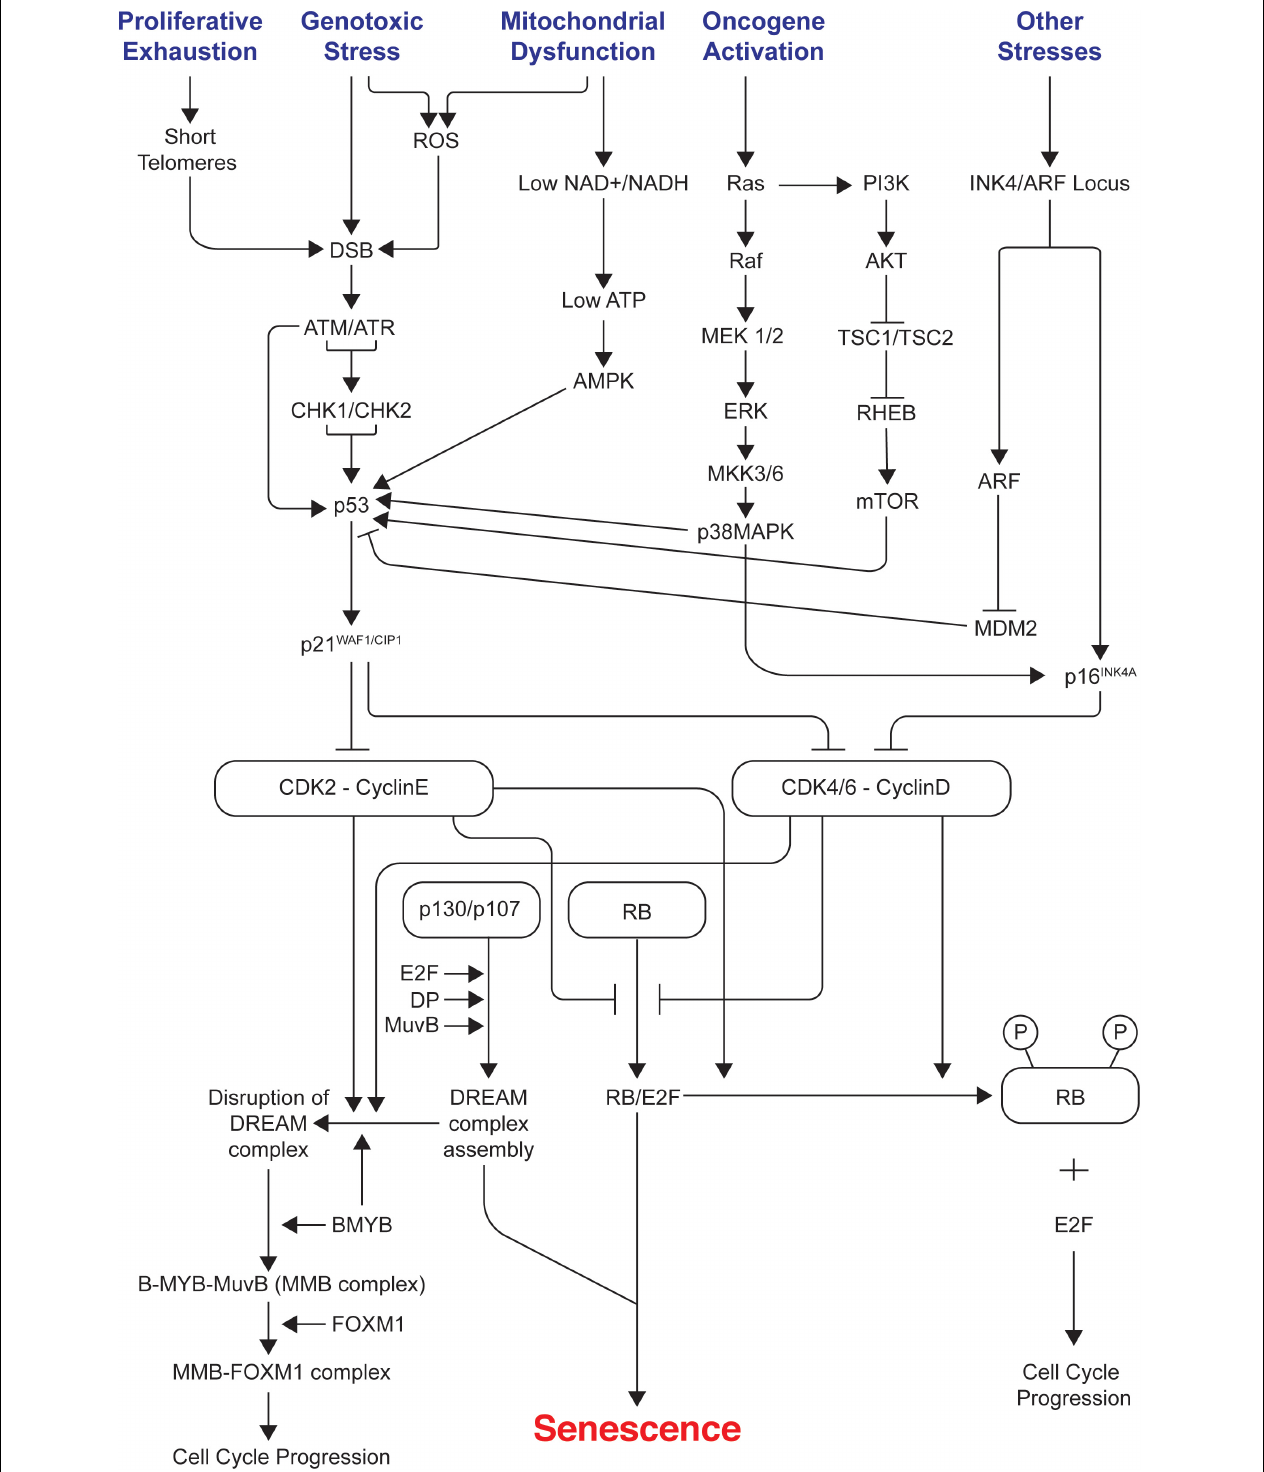
FIGURE 1 | Signals and pathways involved in mediating senescence mediated cell cycle arrest. The figure shows the different intrinsic and extrinsic stimuli capable of inducing cellular senescence. Key pathways involved in manifesting cell cycle arrest in senescence such as p53/p21 WAF1 / CIP1 and p16 INK4A /RB tumor suppressor pathways, DDR, AMPK, p38/MAPK, PI3K/AKT/mTOR are illustrated. It indicates how different pathways are interconnected and how the assembly of repressive DREAM complex triggers senescence and its disruption leads to cell cycle progression. ROS, reactive oxygen species; DDR, DNA damage response; DREAM, dimerization partner (DP), RB-like, E2F, and MuvB core complex.